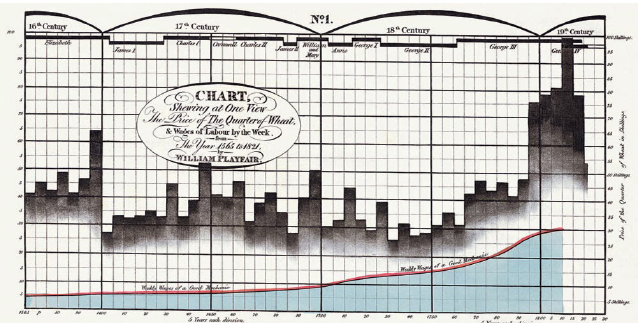
Fig. 4 William Playfair, Chart, Showing at One View The Price of the Quarter of Wheat, & Wages of Labour by the Week from The Year 1565 to 1821 ,